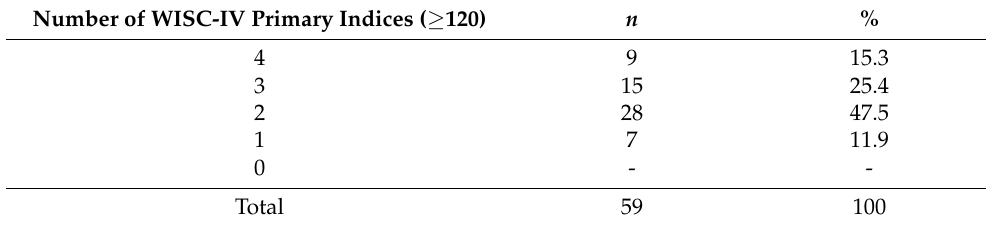
Table 4. Count of WISC-IV primary indices with a score ≥ 120.